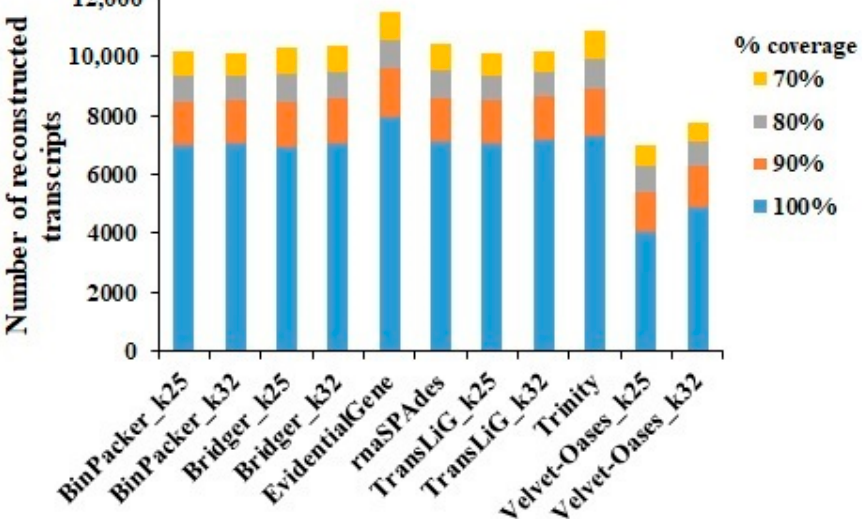
Figure 4. The number of full-length protein-coding genes rebuilt at different coverage depths by each